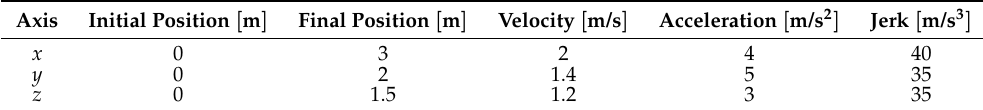
Table 2. Linear trajectory and the maximum motion